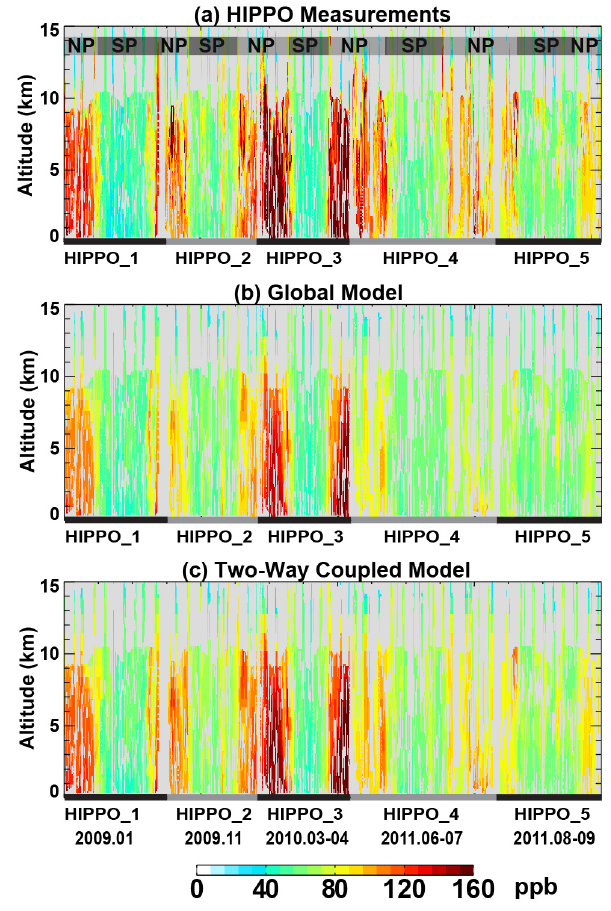
Figure 6. Measured and modeled vertical distributions of tropo- spheric CO along the flight tracks of HIPPO campaigns. Grey de- notes times and locations with no HIPPO data. Data over the North Pacific (NP) and South Pacific (SP) are distinguished in (a)